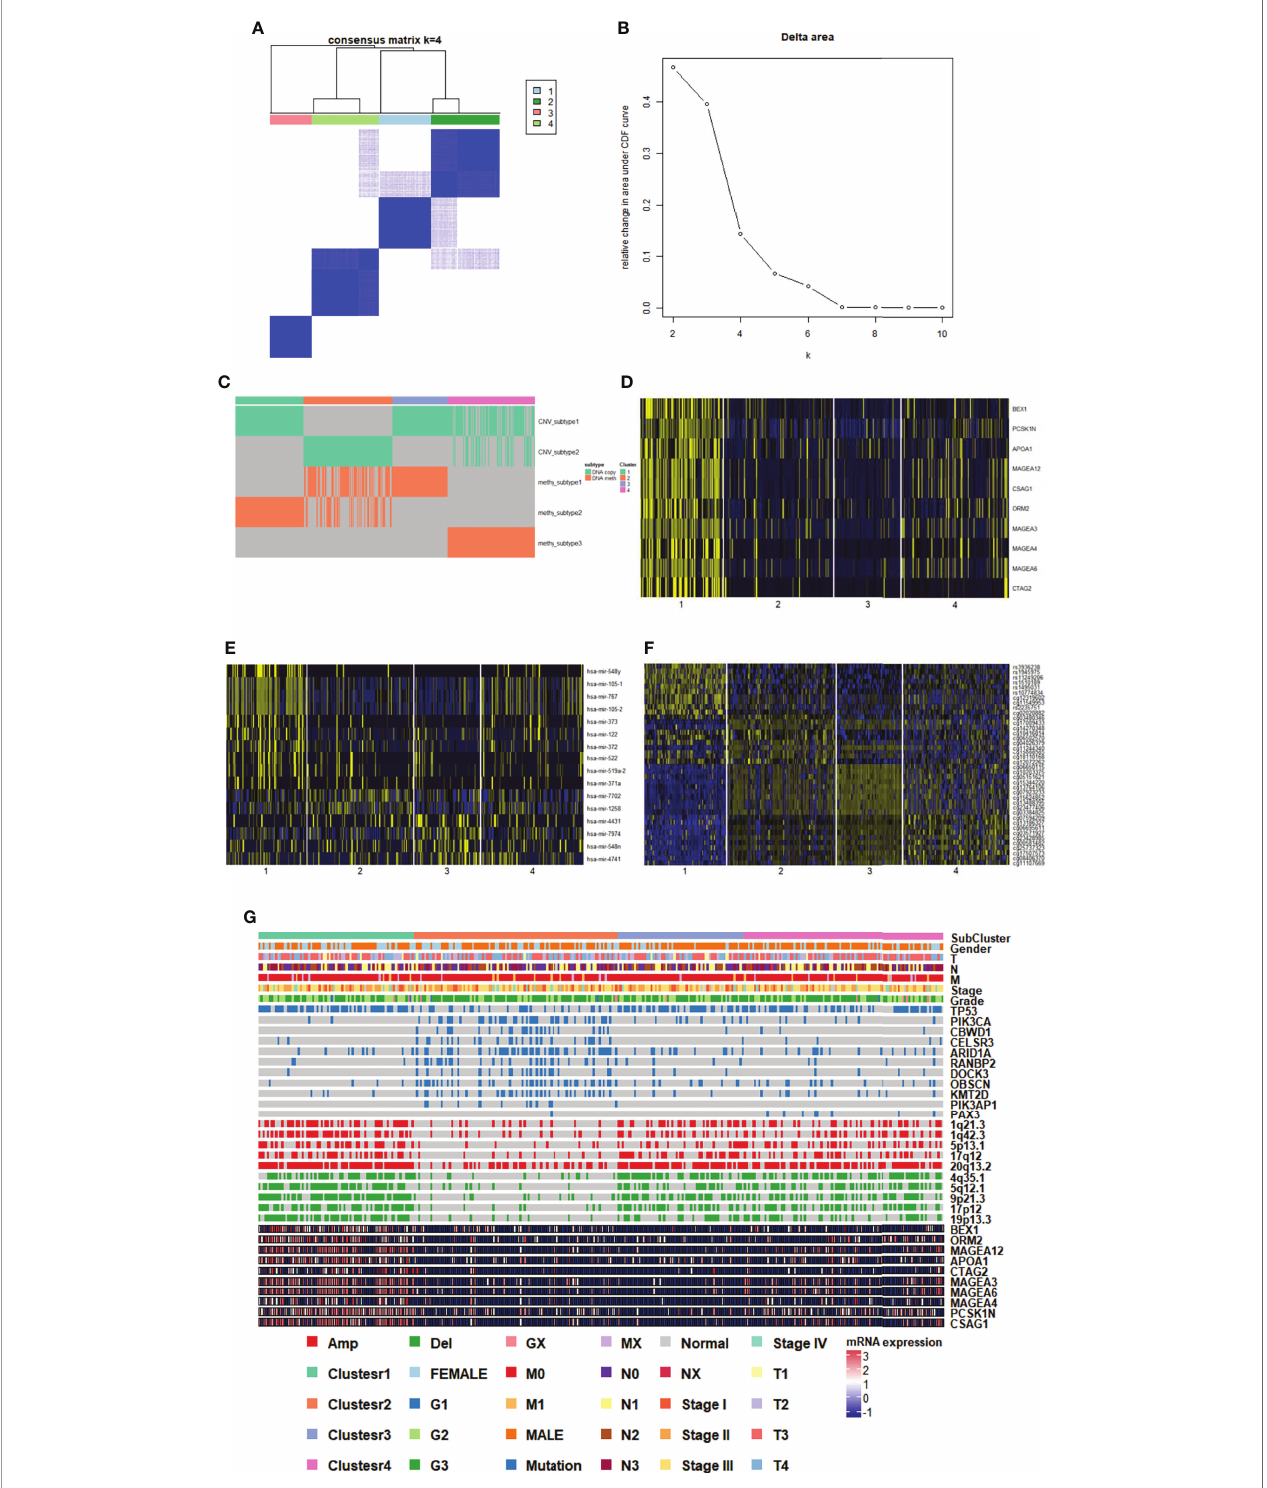
FIGURE 3 | Genomic subtypes of GC in multiplatform analysis. (A, B) The result of clustering analysis based on the multiple platforms. (C) Subgroup distribution and clustering analysis base on single platform. (D) Heatmap of subgroup speci fi c genes. (E) Heatmap of subgroup speci fi c miRNAs. (F) Heatmap of subgroup speci fi c methylation sites. (G) Subgroup features integrated landscape